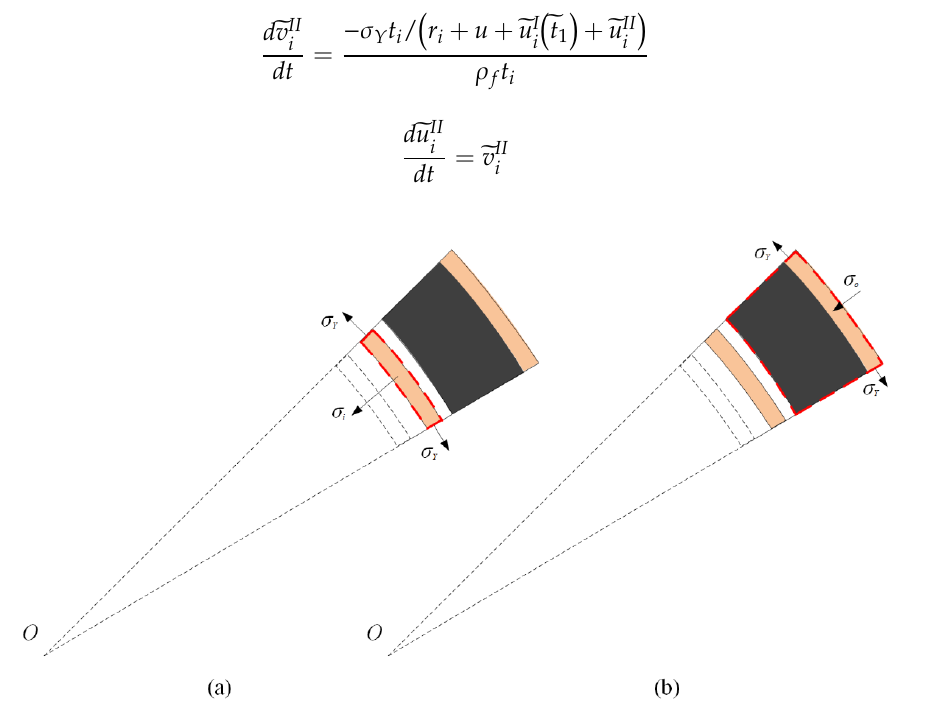
Figure 10. Stress analysis for the sandwich-walled ring in stage II. ( a ) The inner face-sheet, and ( b ) the outer face-sheet.